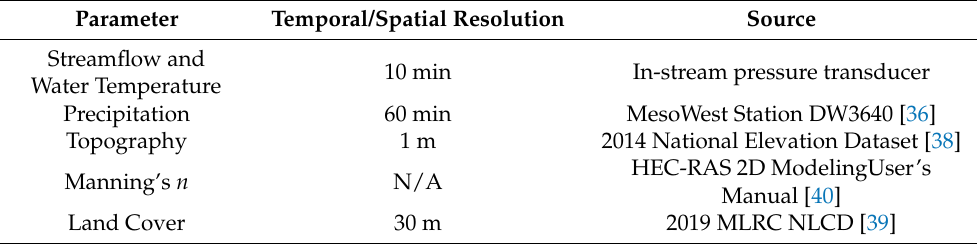
Table 1. Hydrologic and hydraulic parameters for HEC-RAS.